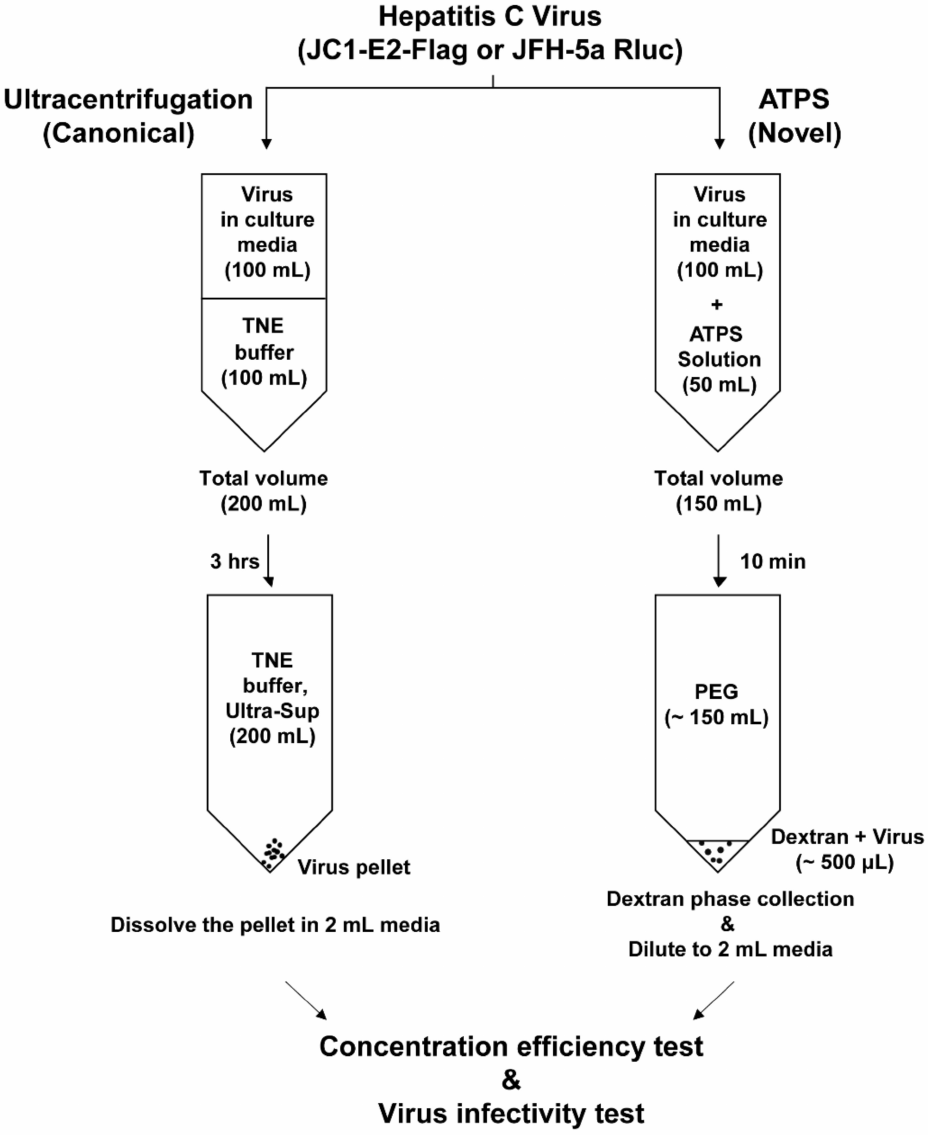
Figure 1. A schematic diagram of hepatitis C virus (HCV) enrichment by ultracentrifugation and the aqueous two-phase system (ATPS). HCV culture media (100 mL) were used in the enrichment processes using either ultracentrifugation ( left panel) or the ATPS ( right panel). Left panel: The HCV culture medium (100 mL) was loaded on top of TNE buffer containing 20% sucrose and then centrifuged at 100,000 × g at 4 ◦ C for 3 h. After centrifugation, the pellet was dissolved in 2 mL of culture medium. Right panel: The HCV culture medium (100 mL) was mixed with 3 × ATPS mixture (50 mL) containing dextran and polyethylene glycol (PEG) in phosphate-buffered saline. ATPS was performed by centrifuging at 1000 × g at 4 ◦ C for 10 min. After the enrichment process, the sample in the dextran phase was diluted with culture medium to a final 2